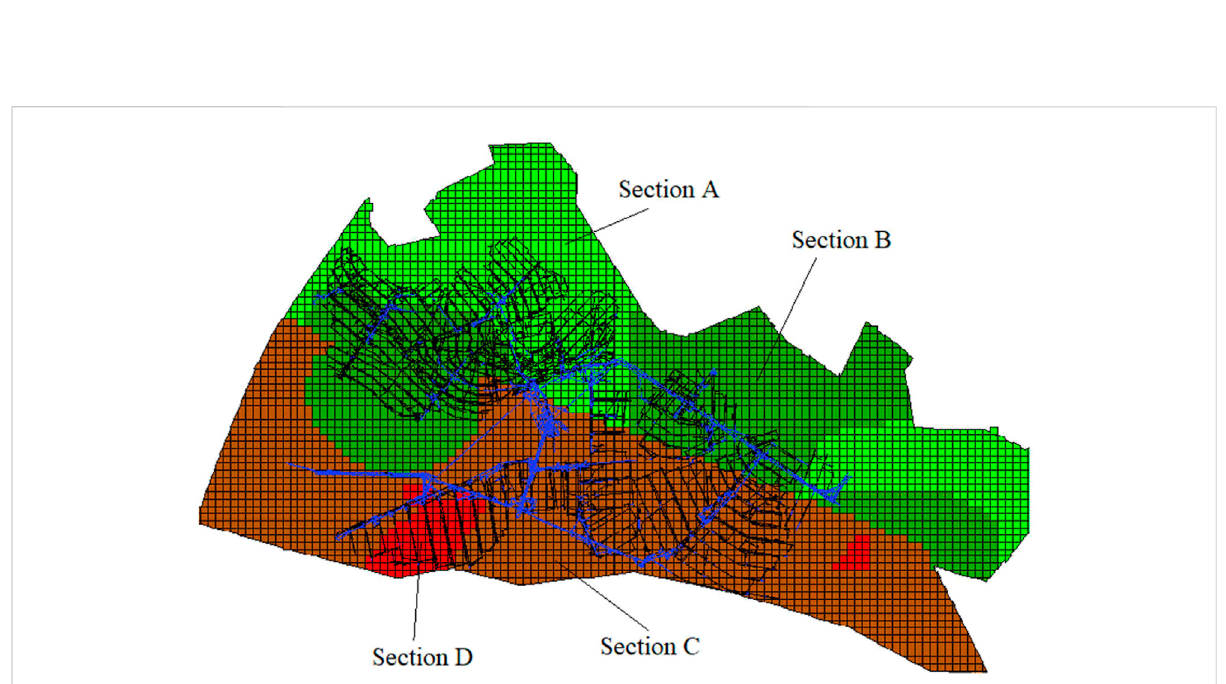
FIGURE 3 Classi fi cation results of hazardous zone of rockburst Section A is non-rockburst zone; Section B is weak rockburst zone, Section C is medium rockbur.